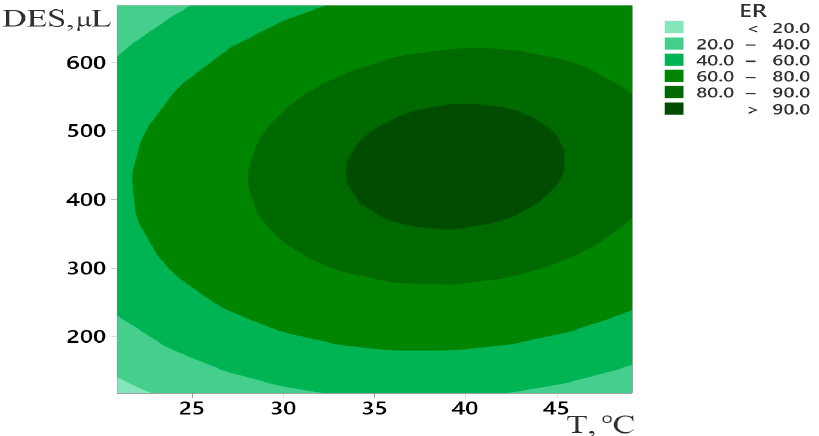
Figure 4. Response surface plot for optimization of RP-DLLME of tryptophan. Figure 3. Response surface plot for optimization of RP-DLLME of